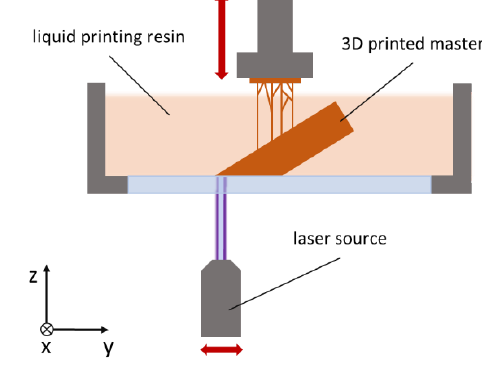
Fig. 1. SLA 3D printing